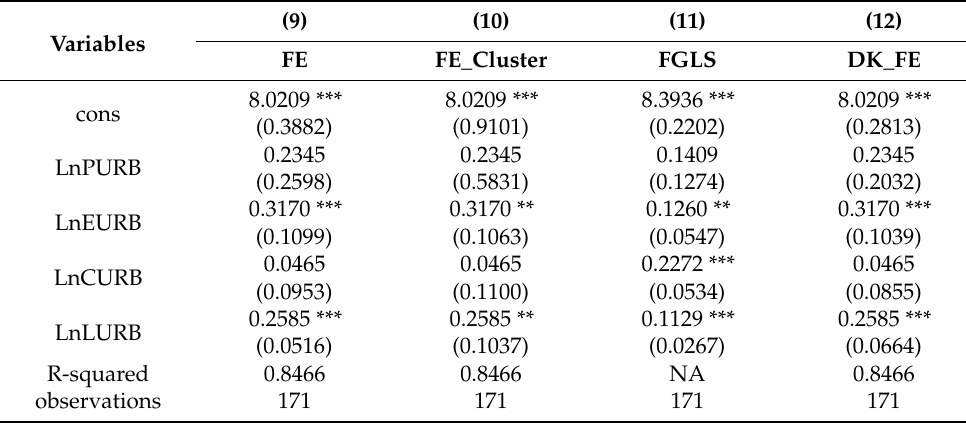
Table 12. Estimation results of central China’s panel